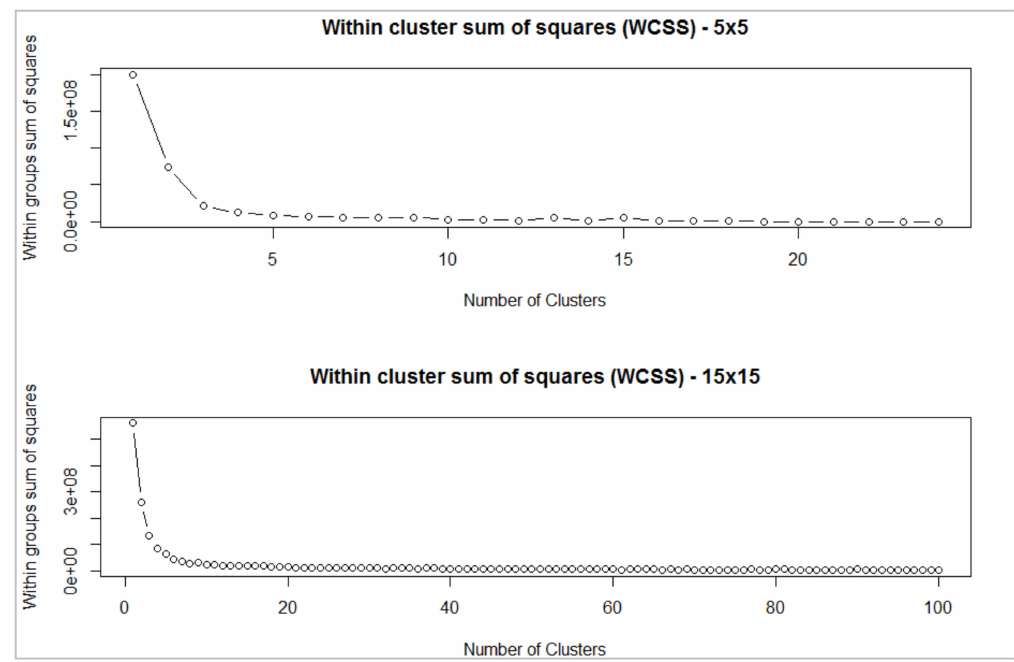
Figure 12. WCSS obtained for the maps 5 × 5 and 15 × 15.